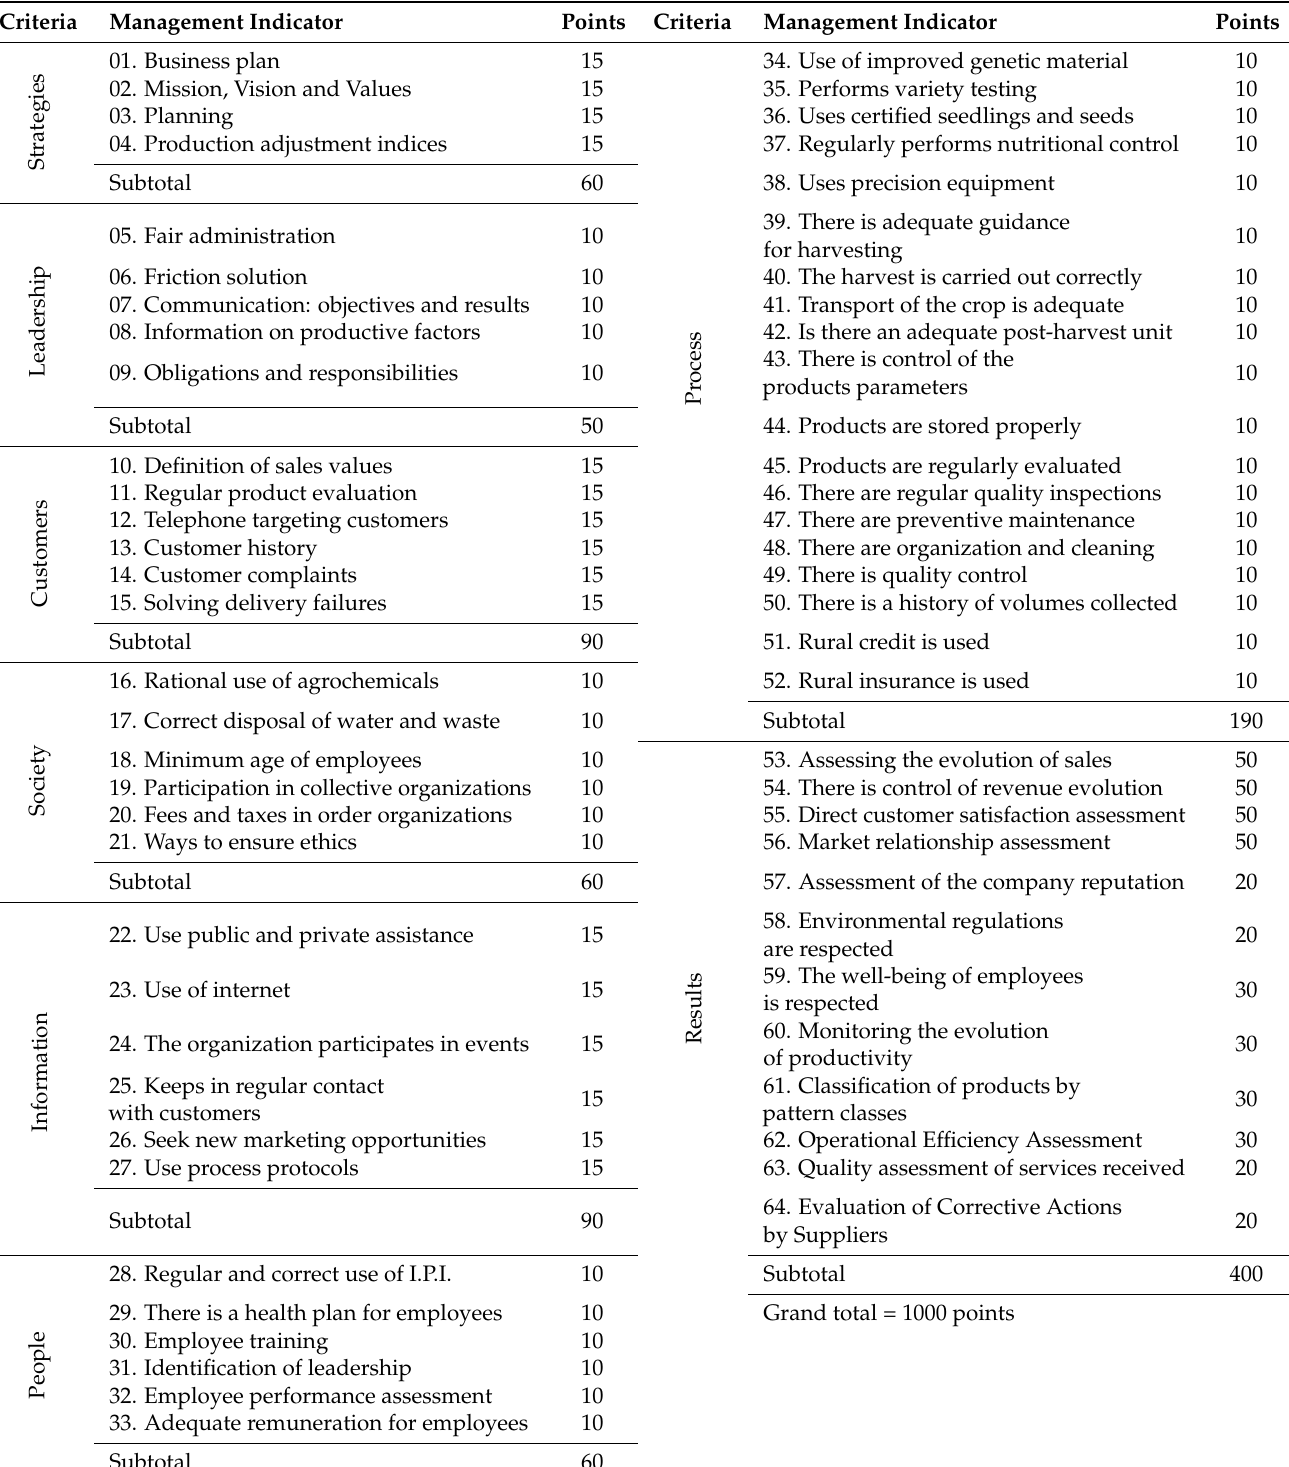
Table 1. Management criteria and indicators: Management Degree Identification Method—MIGG